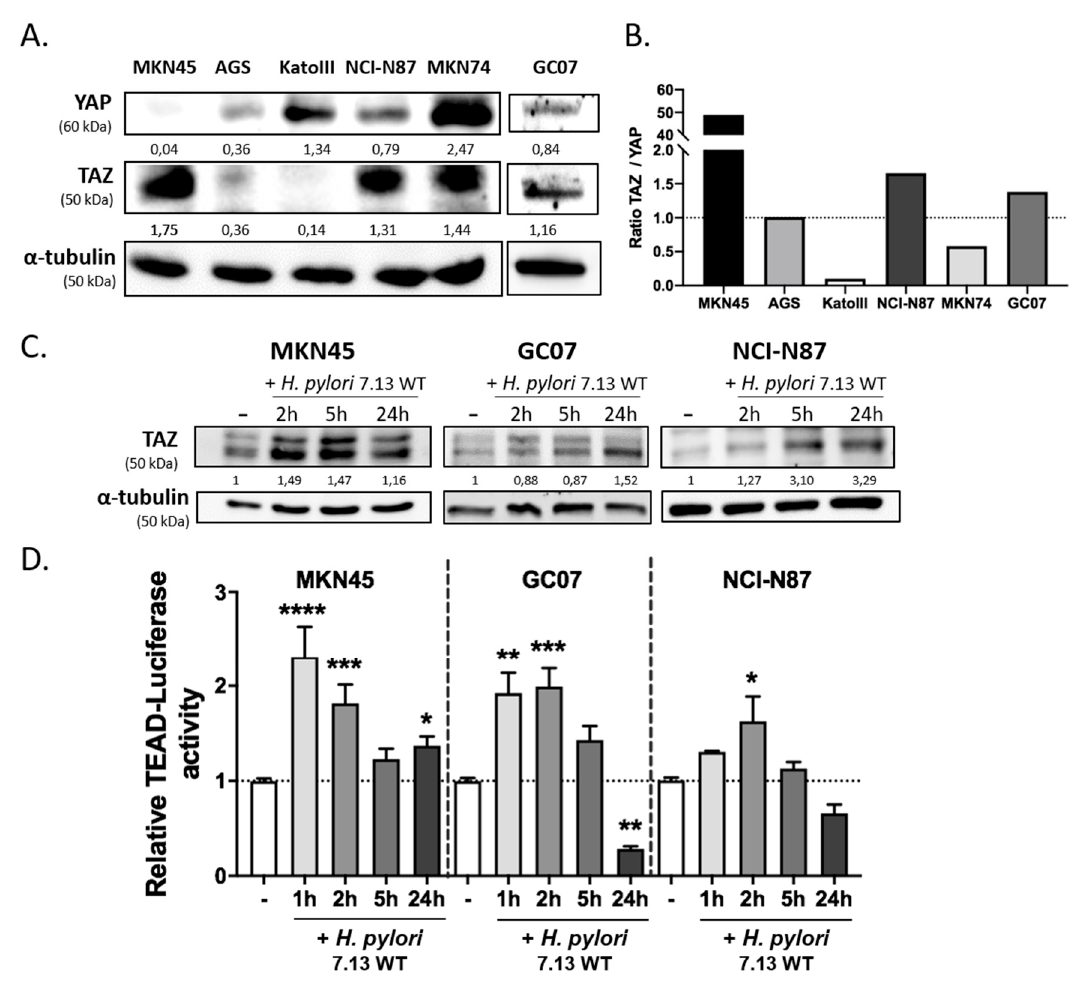
Figure 1. Helicobacter pylori increased transcriptional co-activator with PDZ binding motif (TAZ) protein expression and activated TEA domain (TEAD) transcriptional activity. ( A , B ) Basal expression of TAZ and yes-associated protein (YAP) evaluated in five di ff erent gastric epithelial cell lines and one patient-derived xenograft cell GC07 by Western blot. Numbers under each band correspond to the relative protein expression quantification normalized to the expression of α -tubulin housekeeping protein. ( B ) Representation of the relative expression of TAZ compared to that of YAP in the di ff erent gastric epithelial cells. ( C , D ) Time-course analyses of co-cultures performed with the 7.13 wild type (WT) H. pylori strain and gastric epithelial cell lines MKN45, GC07, and NCI-N87 expressing the most important TAZ / YAP ratio. Uninfected condition corresponds to “–“. ( C ) TAZ protein expression determined during the time-course of 7.13 WT H. pylori strain infection by Western blot. Normalization of the quantification was done in comparison to the uninfected condition and α -tubulin housekeeping protein expression. ( D ) Relative TEAD–luciferase activity determined following 7.13 WT H. pylori infection. Bars represent means ± standard error of the mean (SEM) of fold changes relative to uninfected cells; n = 5, * p < 0.05, ** p < 0.01, *** p < 0.001, **** p < 0.0001 vs. uninfected control, Kruskall–Wallis test with Dunn’s